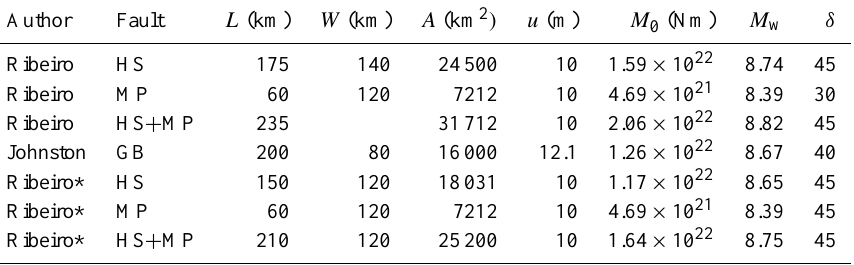
Table 1. Proposed source parameters for the 1755 earthquake ( µ = 6 . 5 × 10 10 Pa). The source parameters indicated as “Ribeiro*” represent a modification of the Ribeiro et al. (2006) proposal, taking into consideration a slight decrease in the maximum seismic rupture allowed. Author